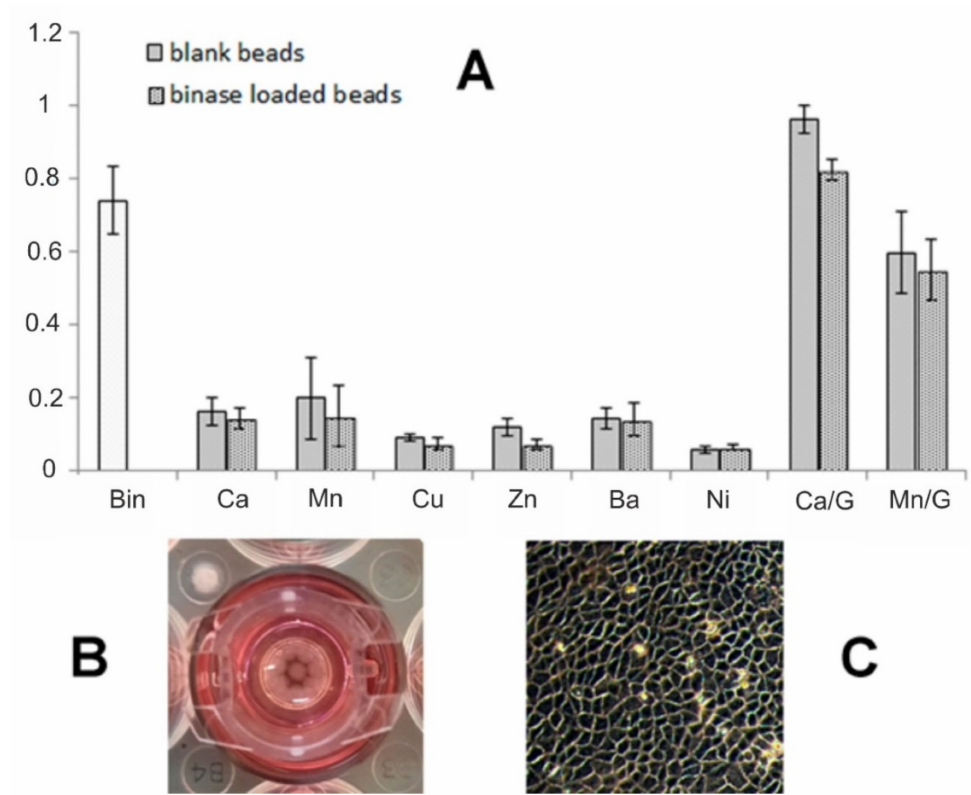
Figure 7. ( A )—HuTu-80 cells viability after 48 h treatment of alginate microspheres stabilized by divalent cations. Bin—the viability in the presence of 100 µ g/mL binase in growth medium. G—ECS with gelatin. ( B )—top view of the well with cultural insert containing studied microspheres. ( C )—monolayer of growing HuTu-80 cells in the well (bottom